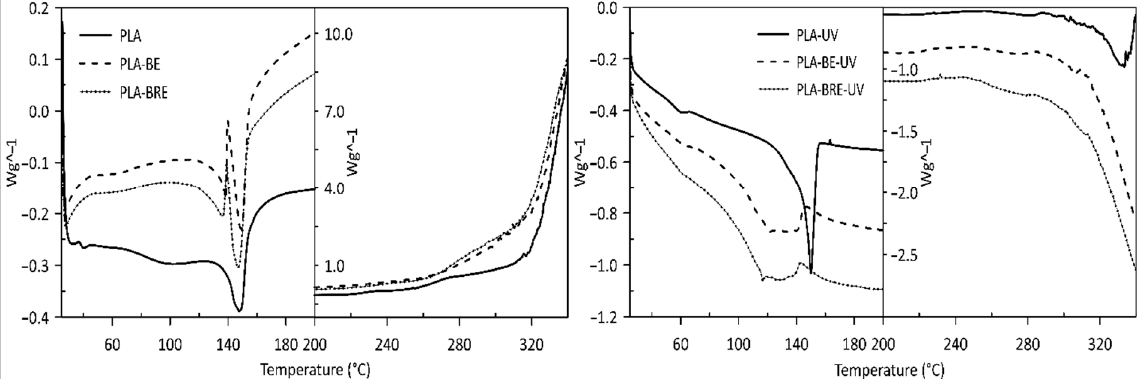
Figure 3. DSC degradation test for the PLA samples under an oxygen atmosphere.